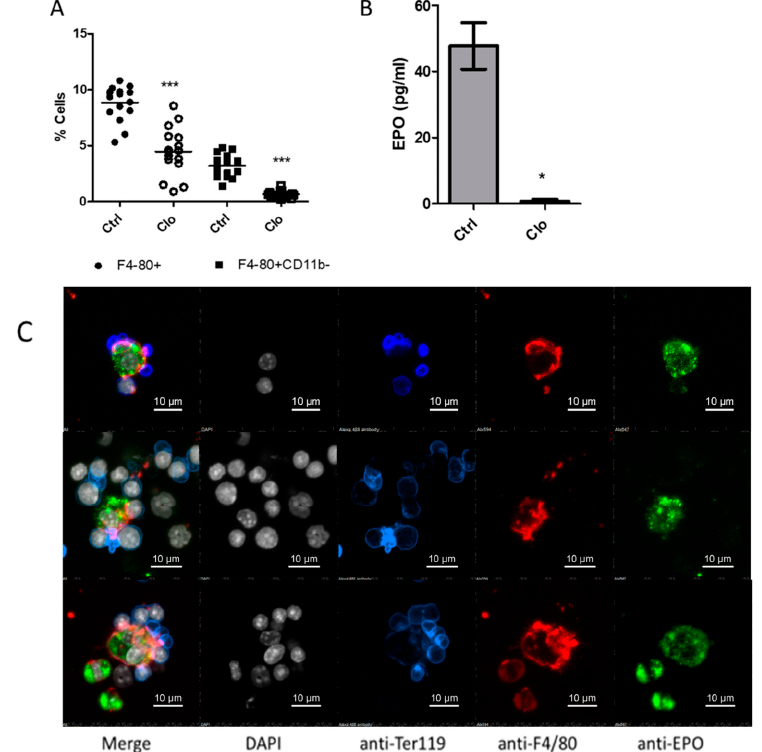
Figure 2. Analysis of EPO concentrations in bone marrow cell lysates from mice depleted of macrophages, and confirmation of EPO expression in erythroblastic island (EBI)-associated macrophages. ( A ) Analysis of F4/80 + and F4/80 + CD11b − cells in the bone marrow (BM) 7 days post-administration of clodronate or PBS-containing liposomes in mice. ( B ) Twenty million BM cells were lysed in RIPA buffer and EPO concentration was assayed by ELISA. ( C ) Total femur cells were flushed and treated with Brefeldin A for 4 hours. Adherent cells were stained with anti-Ter119 Alexa 488 (blue) and anti-F4/80 Alexa 594 (red). Cells were fixed and permeabilized, then stained with anti-EPO Alexa 647 (green) and DAPI (grey). EBI macrophages were identified as F4/80 + cells surrounded by Ter119 + cells. *** p < 0.001, * p < 0.05.